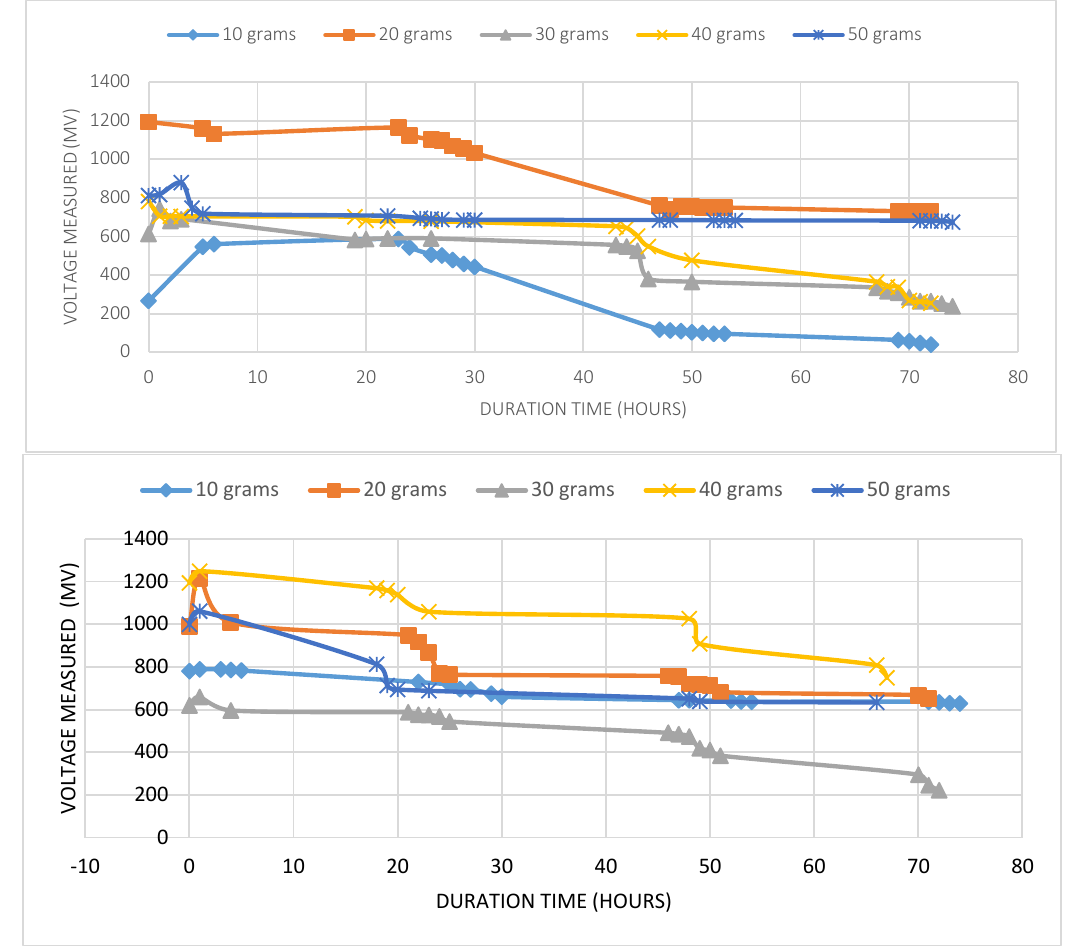
Figure 2: (a) Effect of Orange Peel on voltage reading, (b) Effect of Pineapple Peel on voltage reading From Figure 2(a) and 2(b), it can be seen the data are flactuating at the beginning of experiment. At one moment the number were increasing and decreasing until the end of experiment. It could be observed that the voltage readings suddenly increased at an earlier experiment represents a period where the population of microorganism was continuously doubling. The process of doubling population of microorganism in this phase called exponential phase. This phase been continued until conditions become less favourable [9].